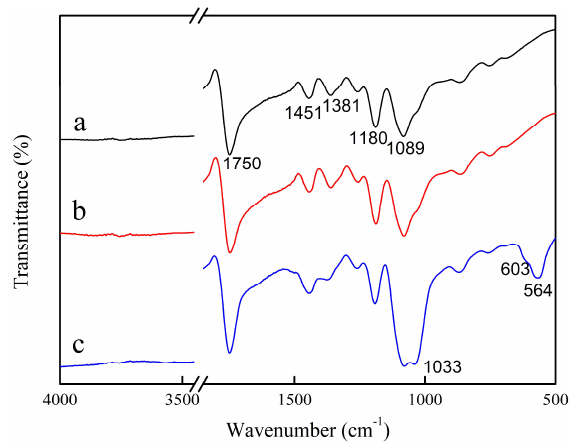
Figure 5. FTIR of ( a ) porous PDLLA membrane; ( b ) porous PDLLA membrane shrank in absolute ethyl alcohol; ( c ) PDLLA/nHA composite fibrous membrane.